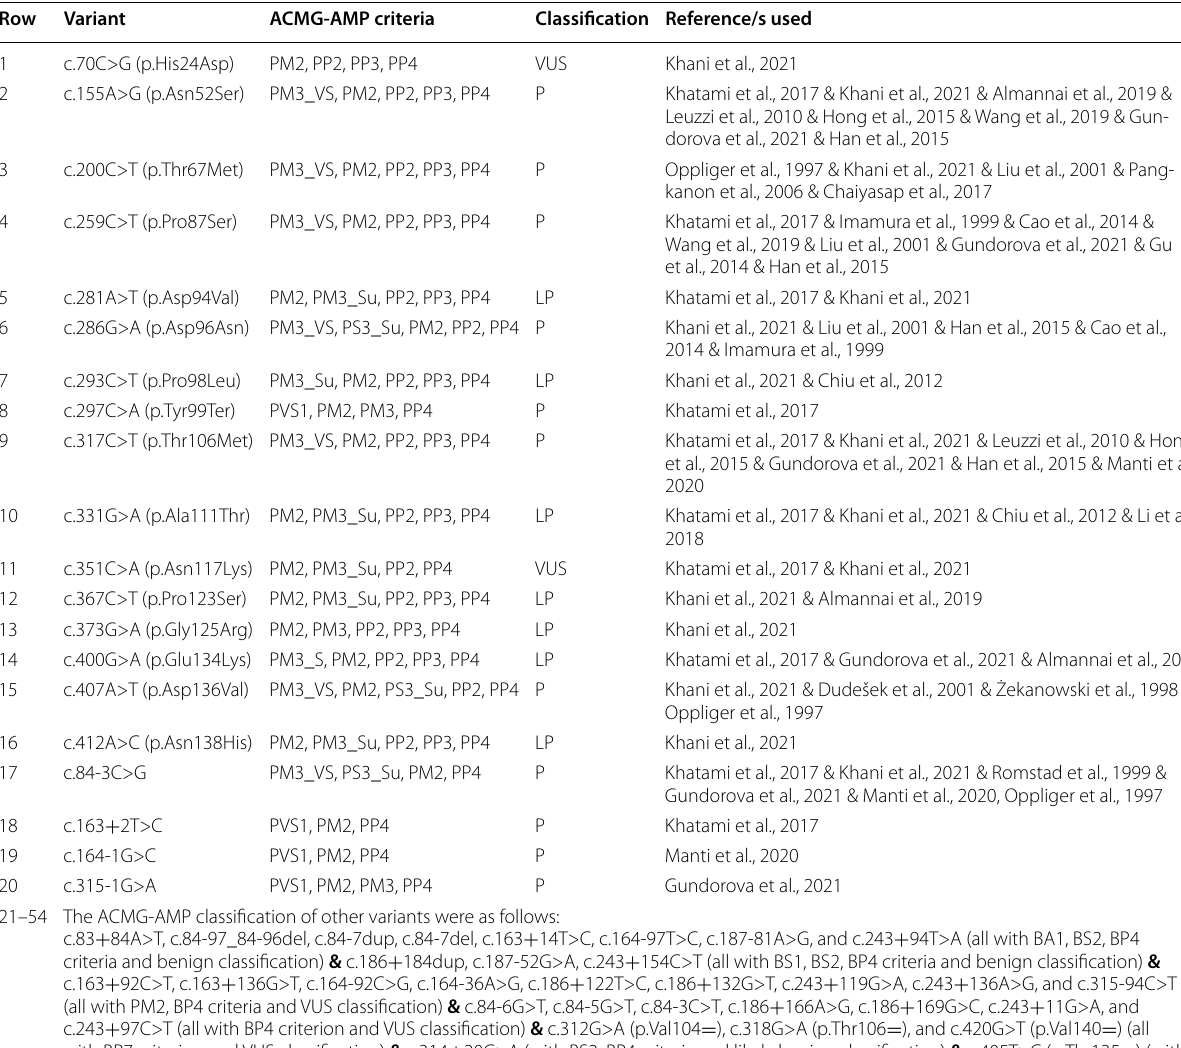
Table 4 ACMG-AMP classification of PTS gene variants reported among Iranian population